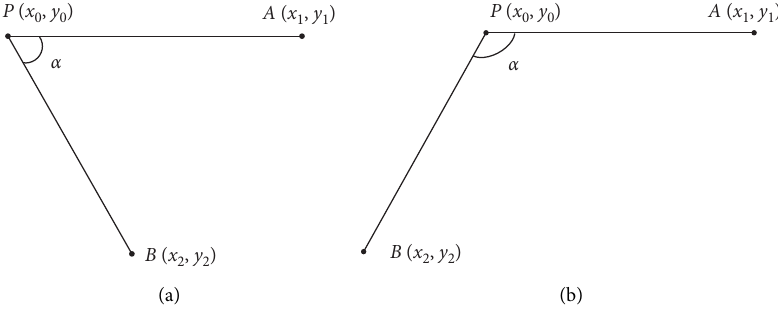
Figure 1: Contour profile point P diagram. (a) The case of 0 < α < π /2. (b) The case of π /2 < α < π .